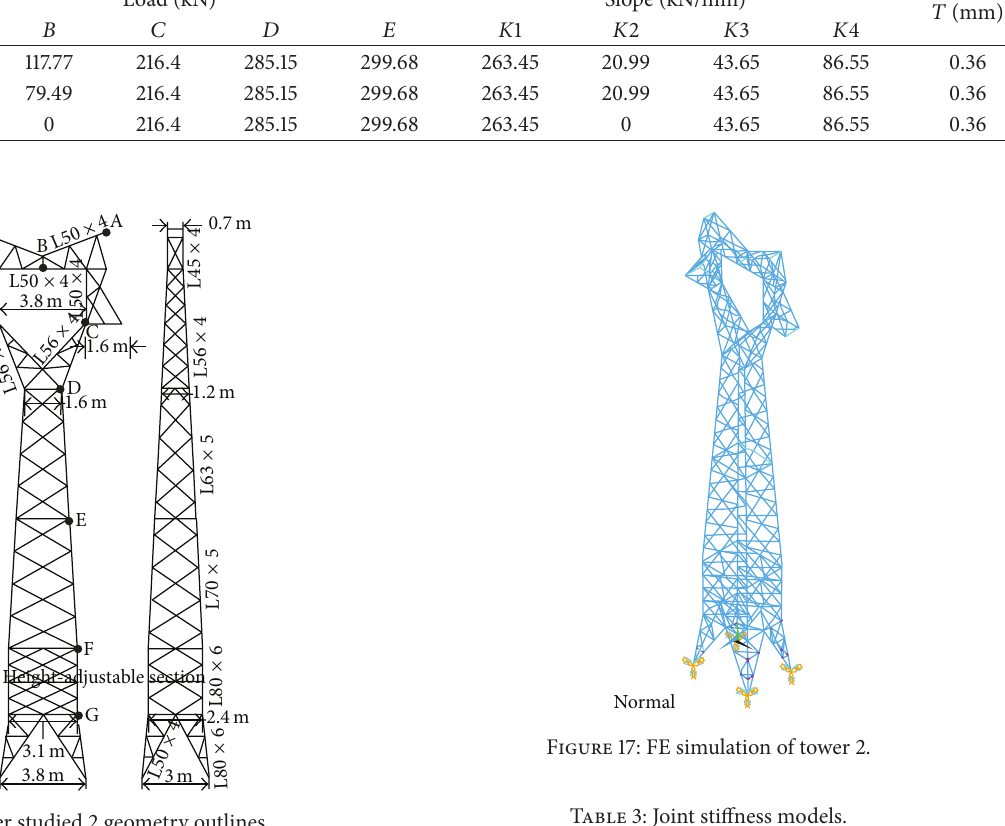
Figure 15: Tower studied 2 geometry outlines.